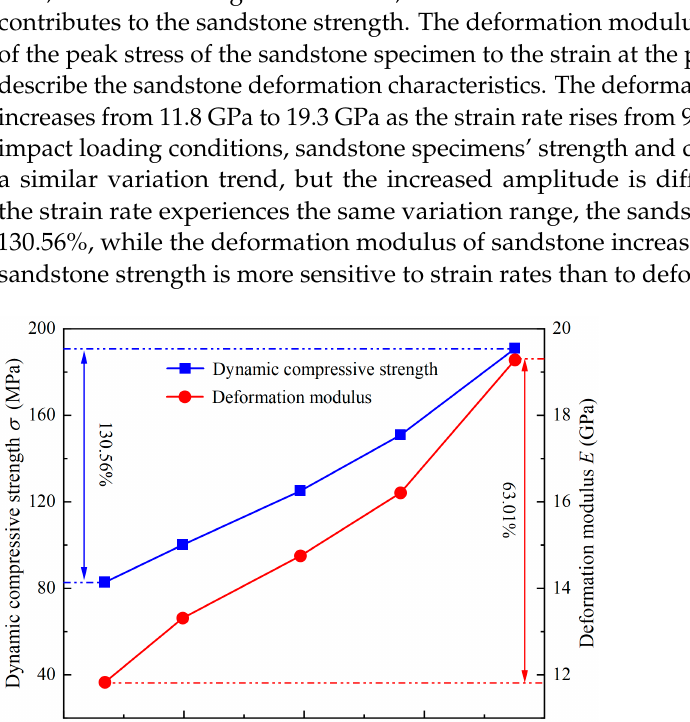
Figure 13. Dynamic stress–strain curves of sandstone at different strain rates.